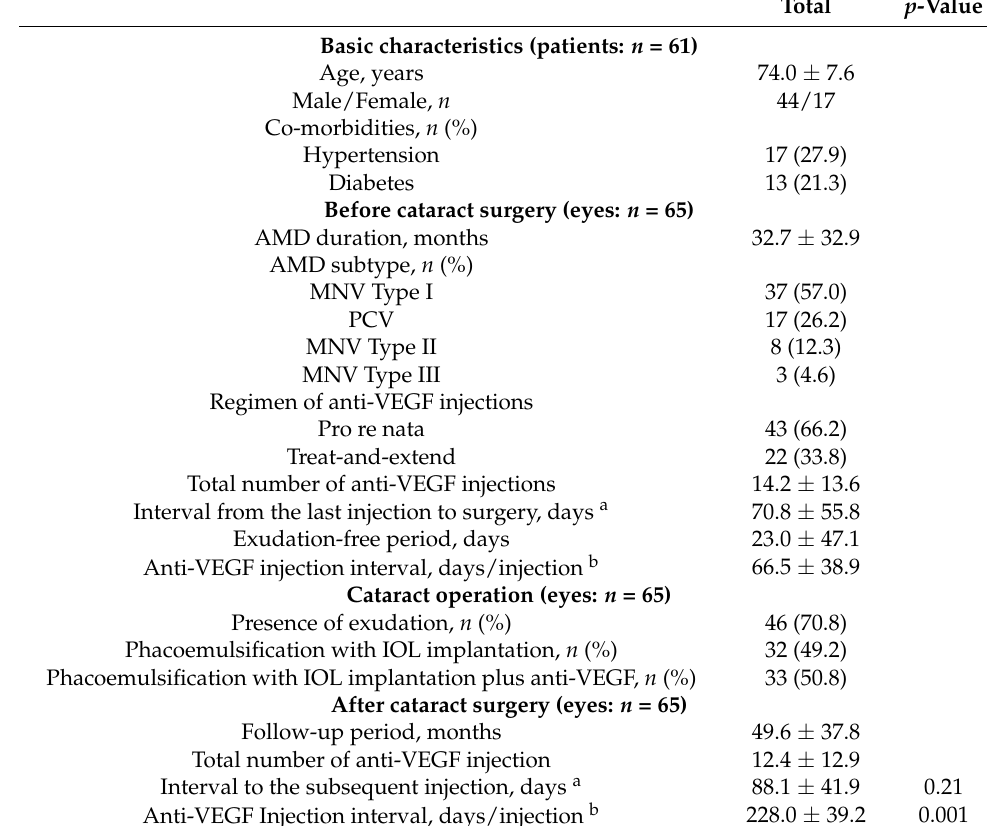
Table 1. Characteristics of patients who underwent cataract surgery during active treatment for